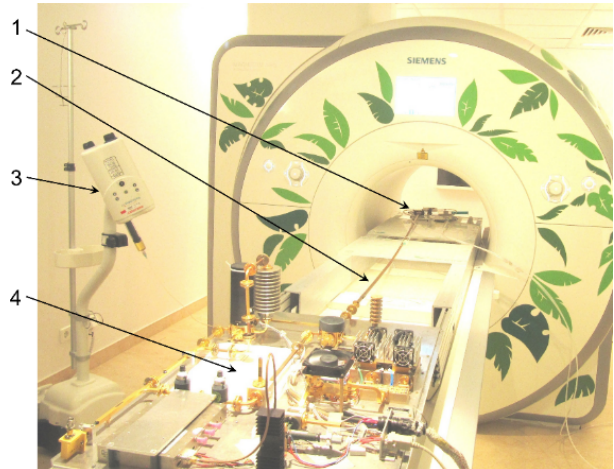
Figure 6. Phantom used for the DNP-MRI measurements. The meander-shaped 0.4mm ID PTFE tubing is mimicking a blood ves- sel. Inlet of the phantom is connected to the resonator via a piece of 0.25mm ID quartz capillary (right-bottom corner of the